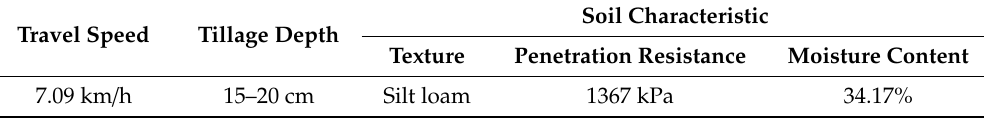
Table 2. Operating conditions of the tractor, and soil environmental conditions of the field